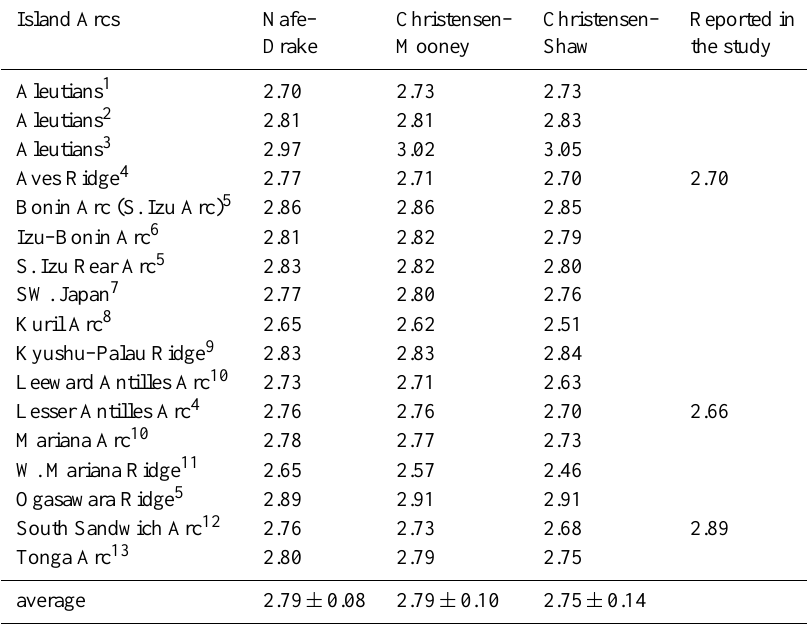
Table 2. Bulk crustal densities (in gcm − 3 ) of modern island arcs determined from seismic velocities using different seismic velocity–density relationships. Crustal densities include the density of the CMTL. Bulk densities are also reported from studies where the authors combined gravity and seismic data to determine crustal density. Island Arcs Nafe– Christensen– Christensen– Reported in